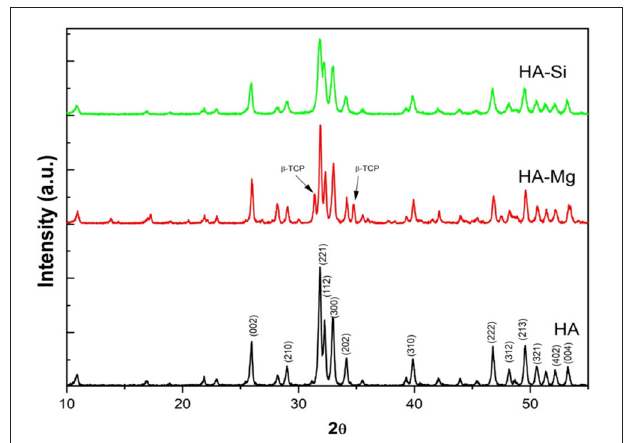
FIGURE 1 | The XRD spectrum of calcined